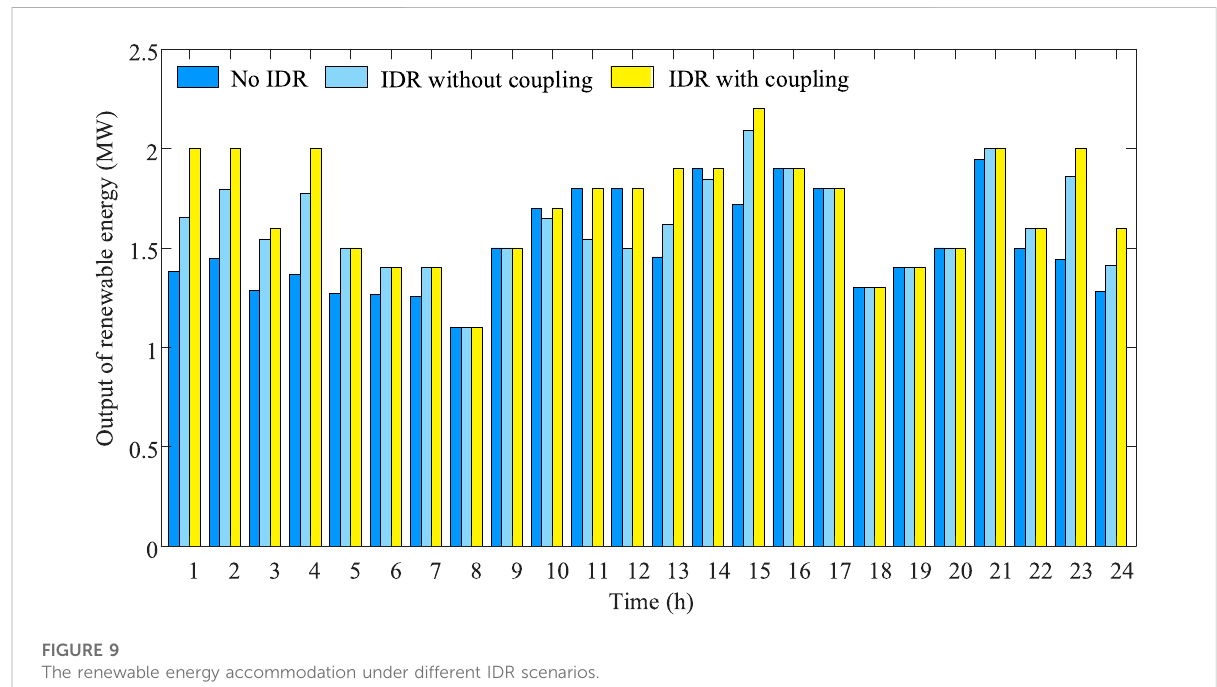
FIGURE 9 The renewable energy accommodation under different IDR scenarios.